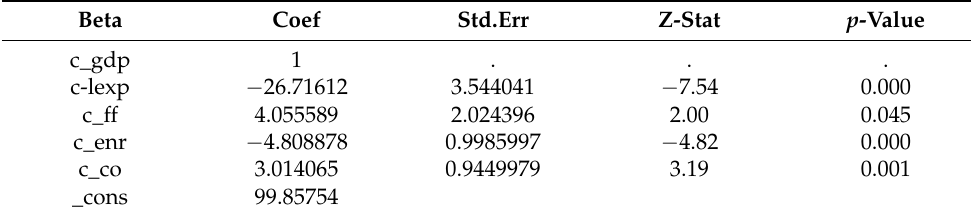
Table 10. Long-run equilibrium equation.